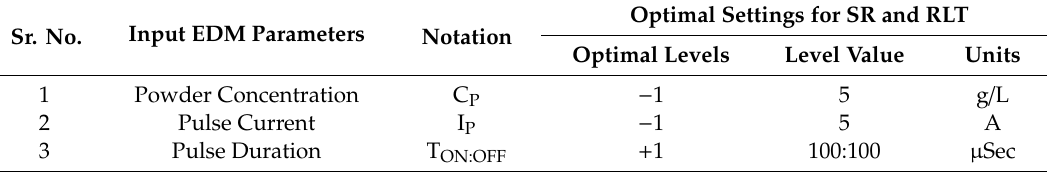
Table 8. Optimized parameters.